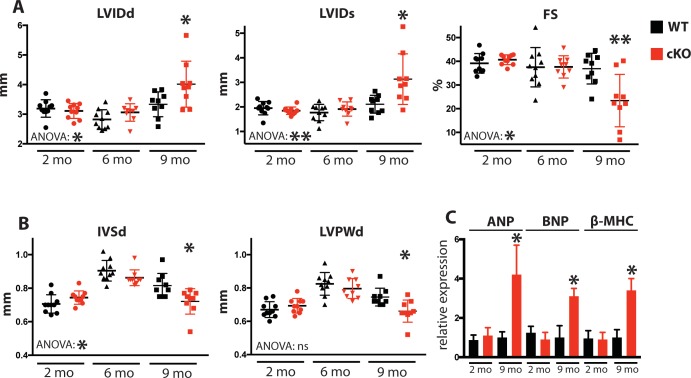
Fam20C cKO mice develop heart failure upon aging.(A and B) Echocardiographic measurements for Fam20CFl/Fl α-MHC-Cre-positive (cKO) and α-MHC-Cre-negative littermate control mice (WT) (n = 10 mice at 2, 6, and 9 months) of (A) LVIDd, LVIDs, LV FS, (B) IVSd, and LVPWd. (C) RT-qPCR of cardiac fetal gene markers of Fam20C WT and cKO mice at 2 and 9 months (n = 3). Data are represented as the mean ±SEM. *p < 0.05; **p < 0.01, or ns (not significant) by Student’s t test or ANOVA (when indicated) for WT v. cKO.